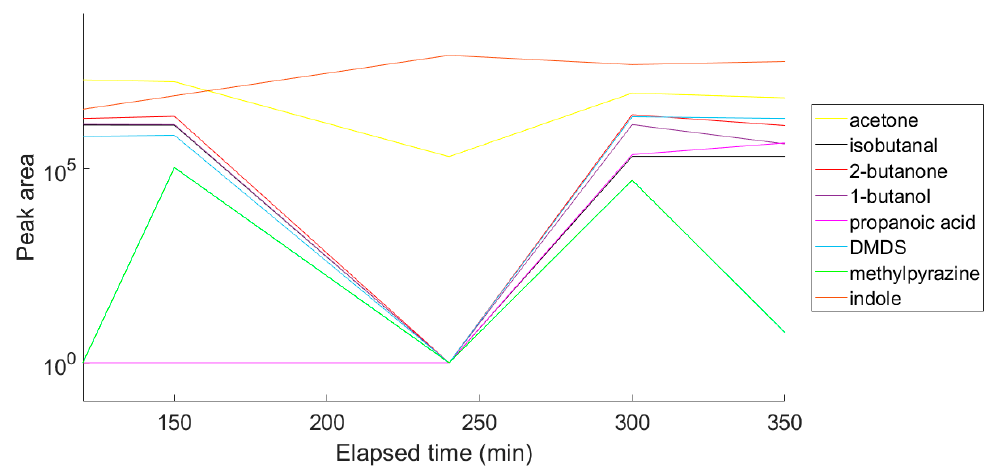
Figure 4. Variation in concentration of nine VOCs over time as a laboratory strain of E. coli grown in broth culture.